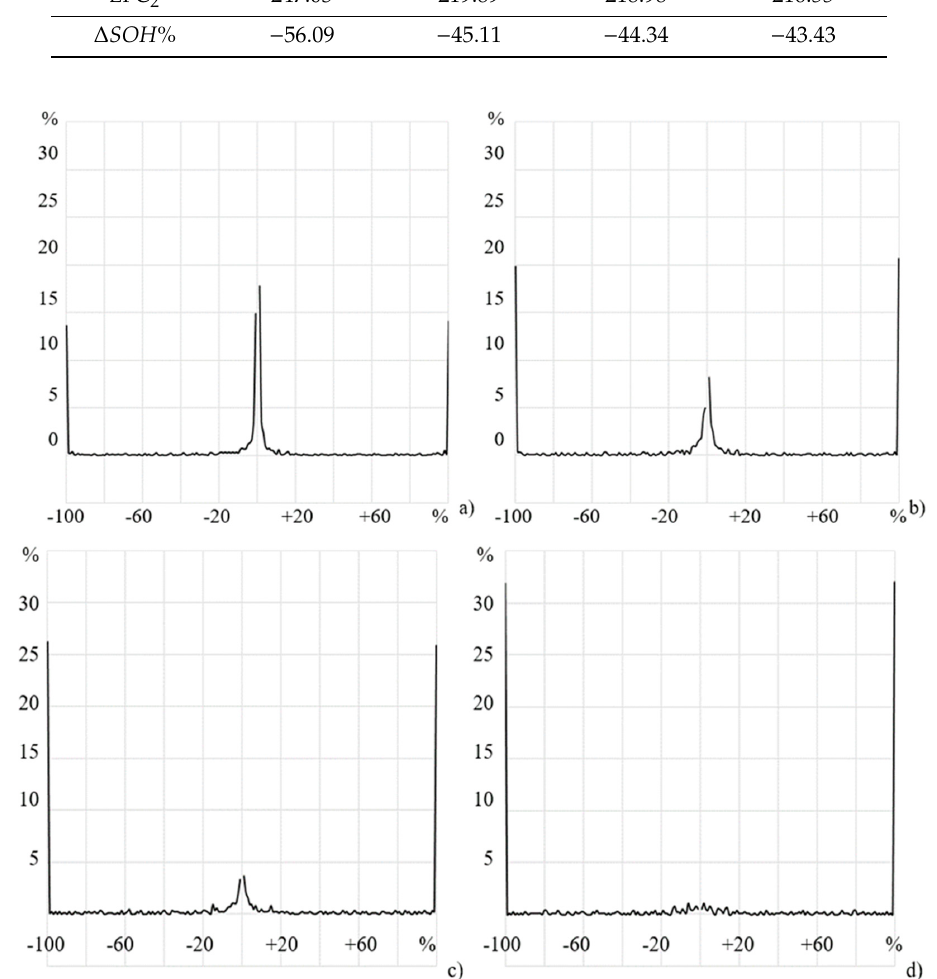
Figure 8. SOC substrings from 1 to 10 January for ( a ) 3 min; and ( b ) 60 min temporal resolution.